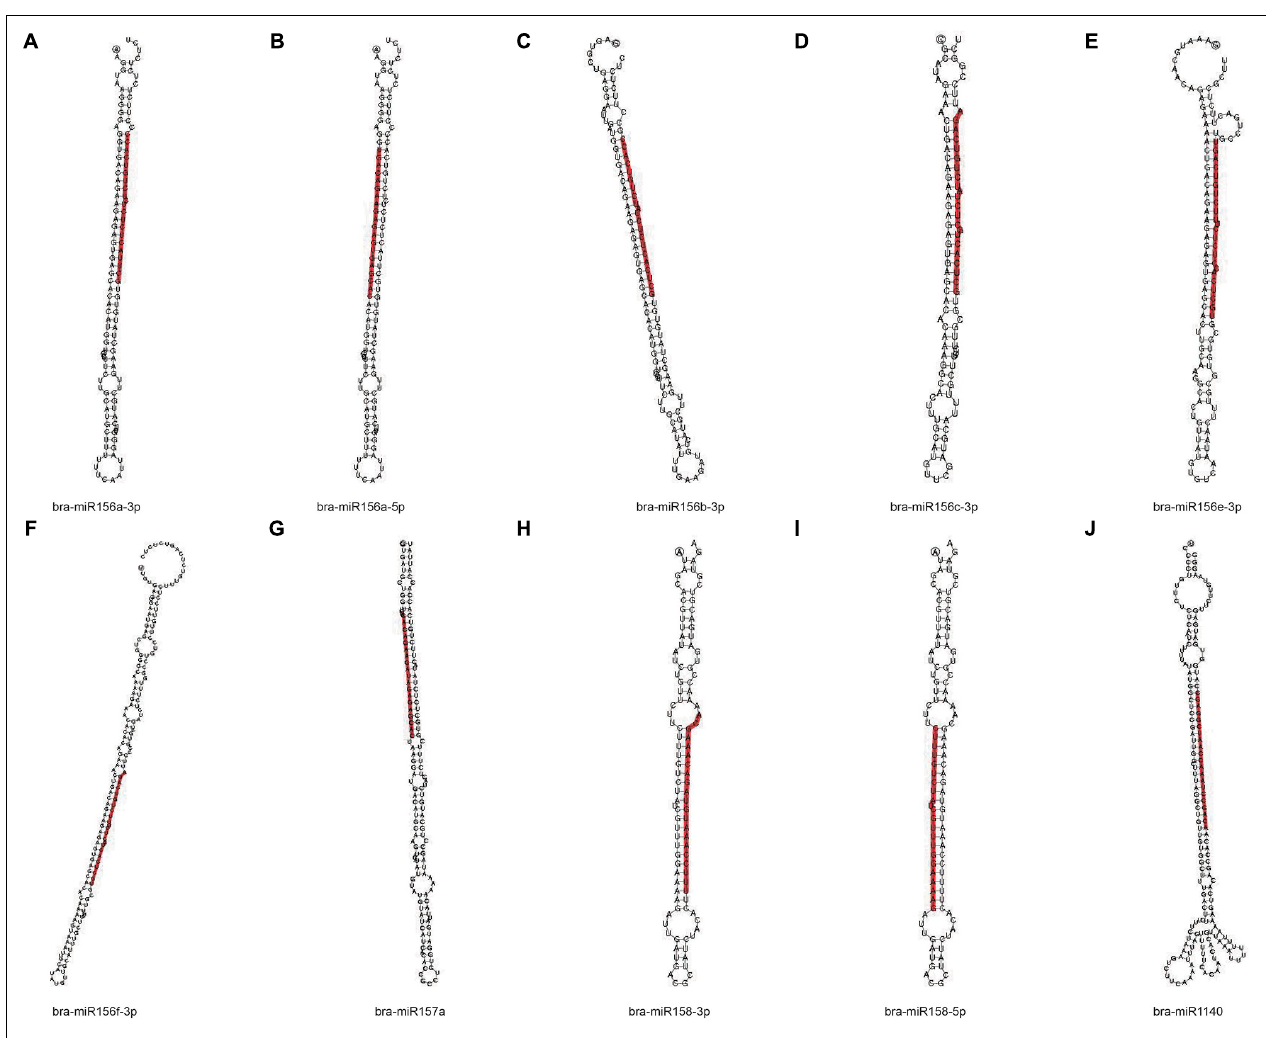
FIGURE 9 | Secondary structure of the known miRNA on the match. (A–J) Secondary structure of 10 known miRNAs on the match from Pak-choi. The entire sequence is miRNA precursor, and the red highlight is where the mature sequence is located.